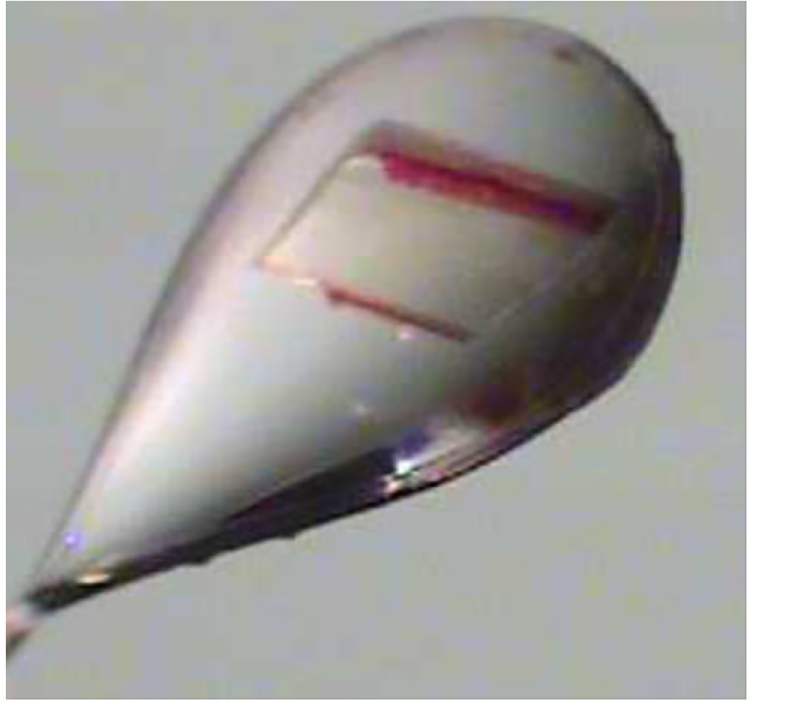
Fig 1. Galangin data crystal showing the color